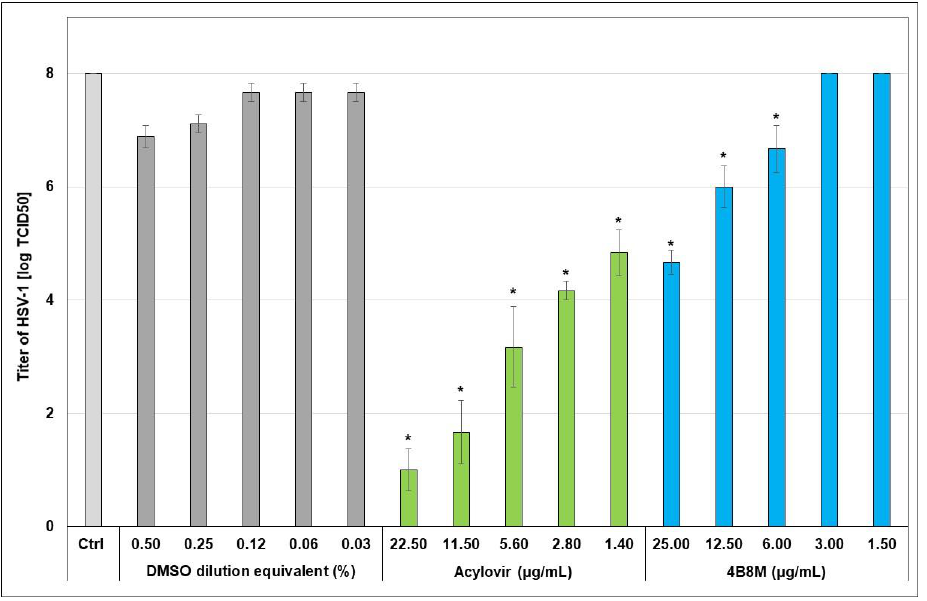
Figure 6. The effect of 4B8M on HSV-1 virus replication in A-549 cells. A-549 cells were infected with HSV-1 of MOI=4 and, after 1 h of virus absorption at 37 °C, the virus inoculum was removed and the infected cells were incubated for 48 h with 4B8M (25.0; 12.5; 6.0; 3.0; 1.5 μg/mL), DMSO as the solvent control for 4B8M or medium only (Ctrl). Acyclovir (22.5; 11.2; 5.6; 2.8 and 1.4 μg/mL) was used as a reference drug. The viral titer was expressed with reference to the TCID50 value, based on the cytopathic effect caused by this virus in approximately 50% of infected cells. The results, obtained from 4 independent experiments (mean ± SE), are presented as the logTDIC50 values in relation to appropriate DMSO control. * p < 0.05 as compared with appropriate DMSO controls.